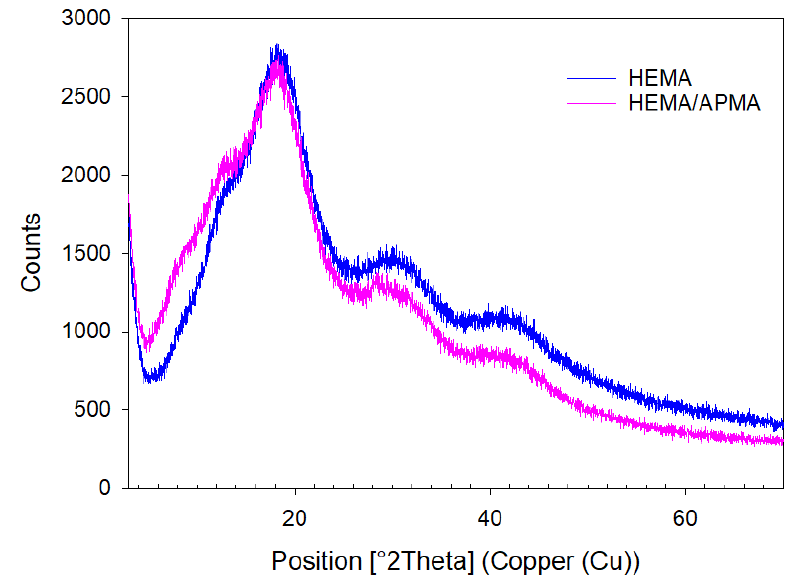
Figure 3. X-ray powder diffraction (XRPD) patterns of HEMA and HEMA/APMA contact lenses.